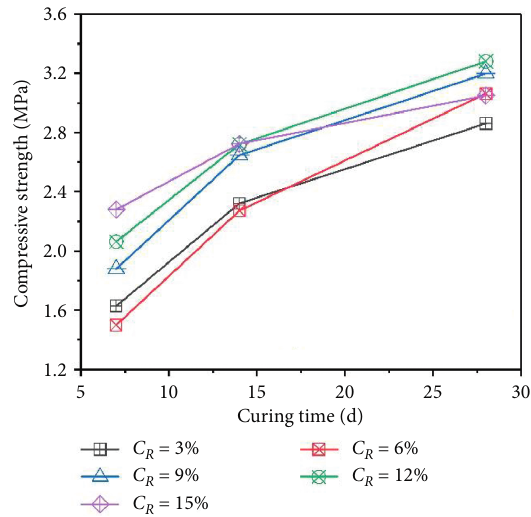
Figure 4: The relationship between compressive strength and curing